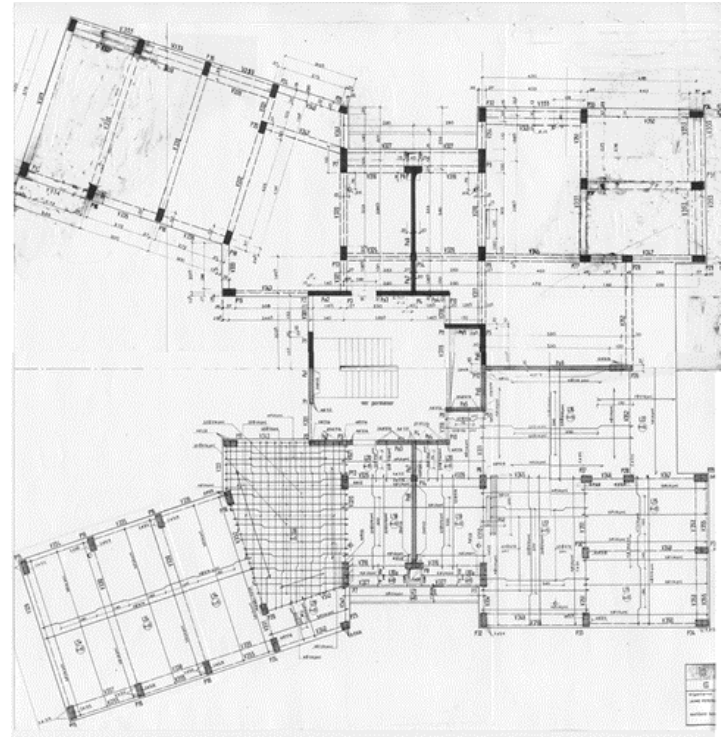
Figure 17. Plan of the structure.